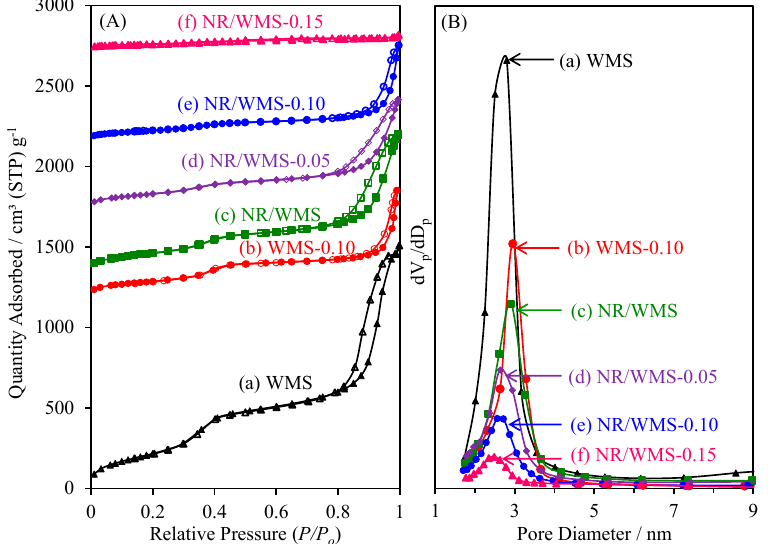
Figure 5. ( A ) N 2 adsorption–desorption isotherms and ( B ) BJH pore size distribution of (a) WMS, (b) WMS-0.10, (c) NR/WMS, (d) NR/WMS-0.05, (e) NR/WMS-0.10 and (f) NR/WMS-0.15.